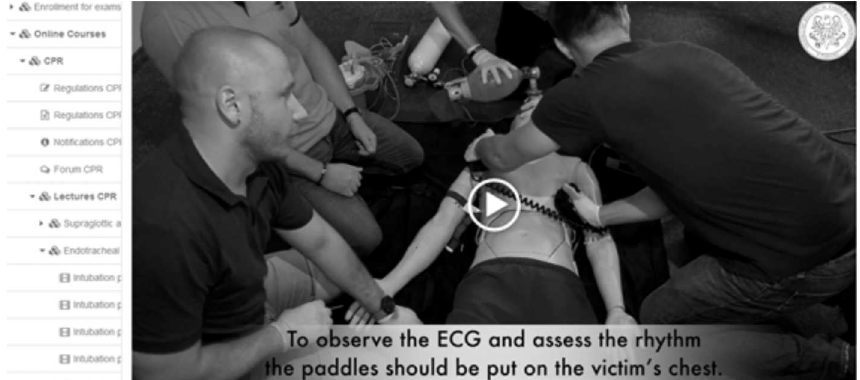
Figure 3. The written comments used in the ALS movie during freeze-frame